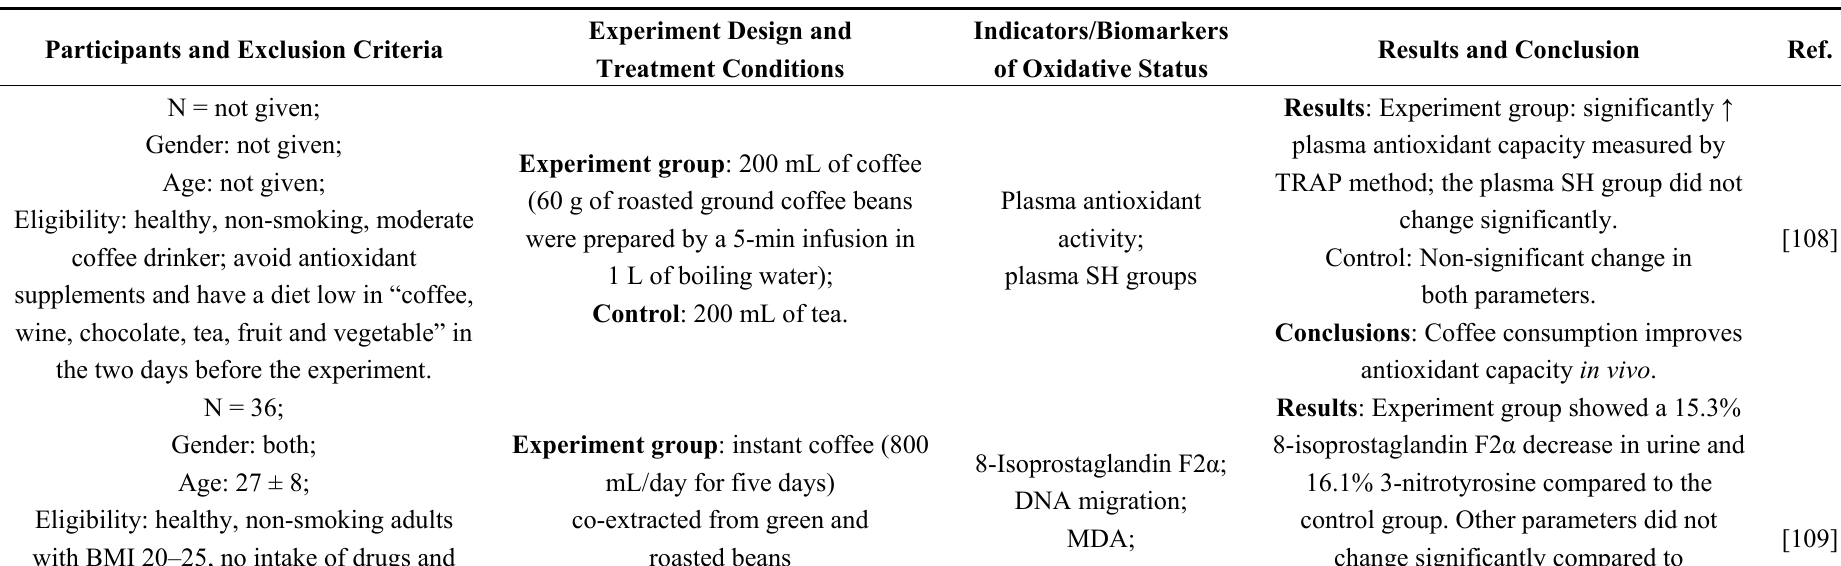
Table 3. Summary of clinic studies evaluating the effects of coffee consumption on modulating oxidative status in healthy subjects or subjects with diseases associated with oxidative